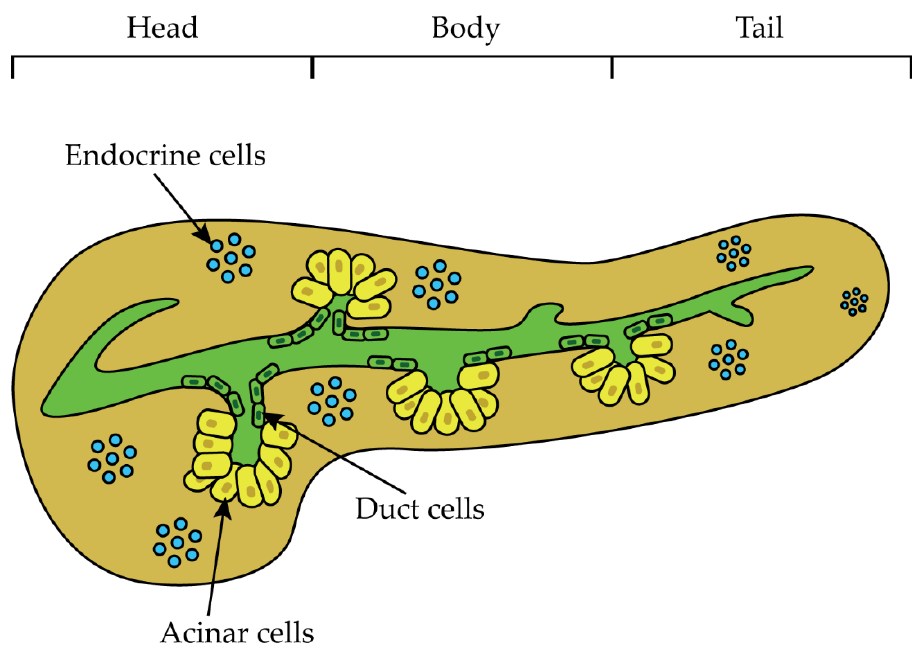
Figure 1. Pancreas anatomy. Macroscopically the pancreas is subdivided into three different parts named the head, body, and tail. Microscopically, it is composed of three main cell types: the endocrine cells designated for the release of hormones, acinar cells, which produce digestive enzymes, and duct cells secreting bicarbonate [4].